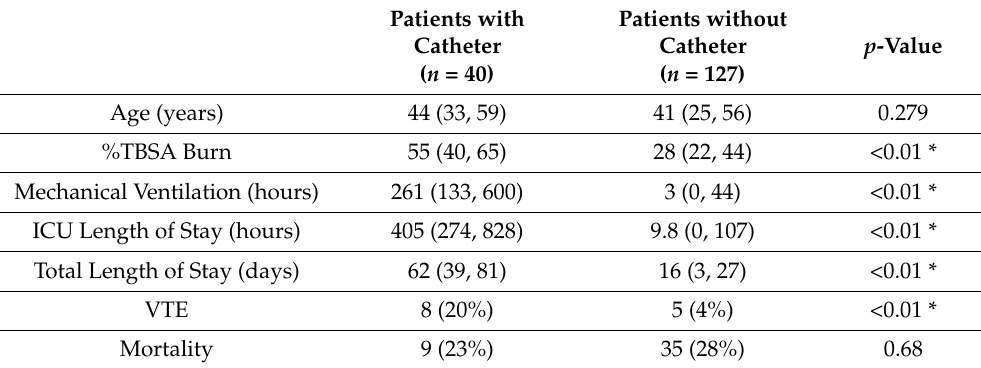
Table 1. Characteristics of patients with total body surface area affected (TBSA) >20% according to insertion of intravascular warming catheter.